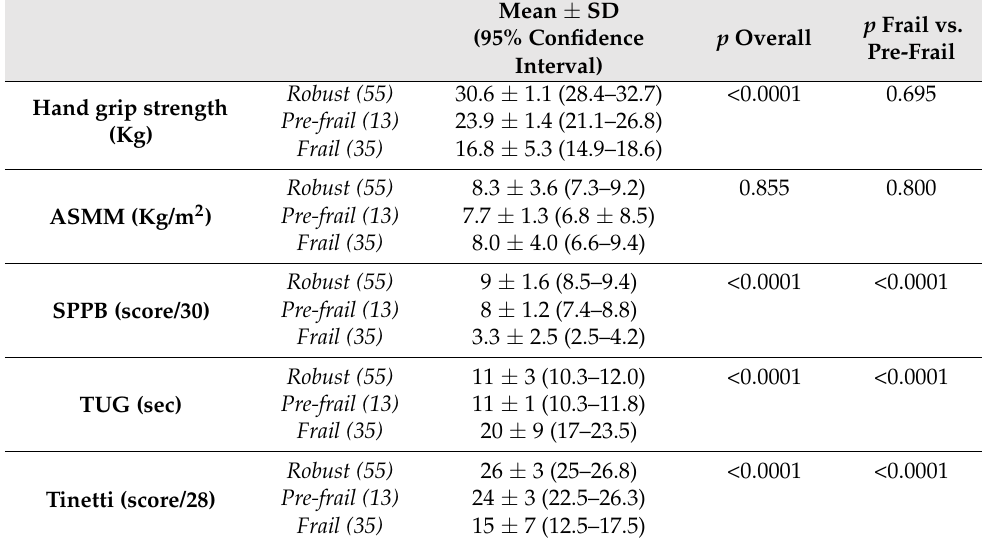
Table 3. Muscle health amongst the subjects classified according to the FP criteria . Mean and SD with CI are shown, and the p -values were calculated with one-way ANOVA.